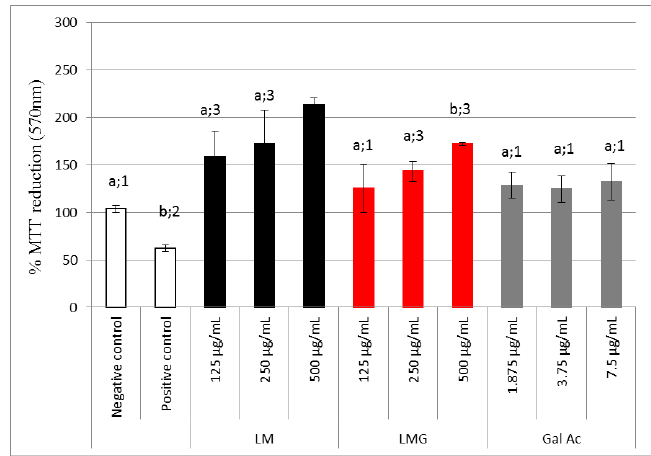
Figure 9. MTT-reducing activity of MDCK cells treated with H 2 O 2 together with LMG for 24 h (protective effect). Values are expressed as mean ± standard deviation. Different numbers represent a significant difference between controls and LMG ( p < 0.05). Gal Ac—gallic acid.